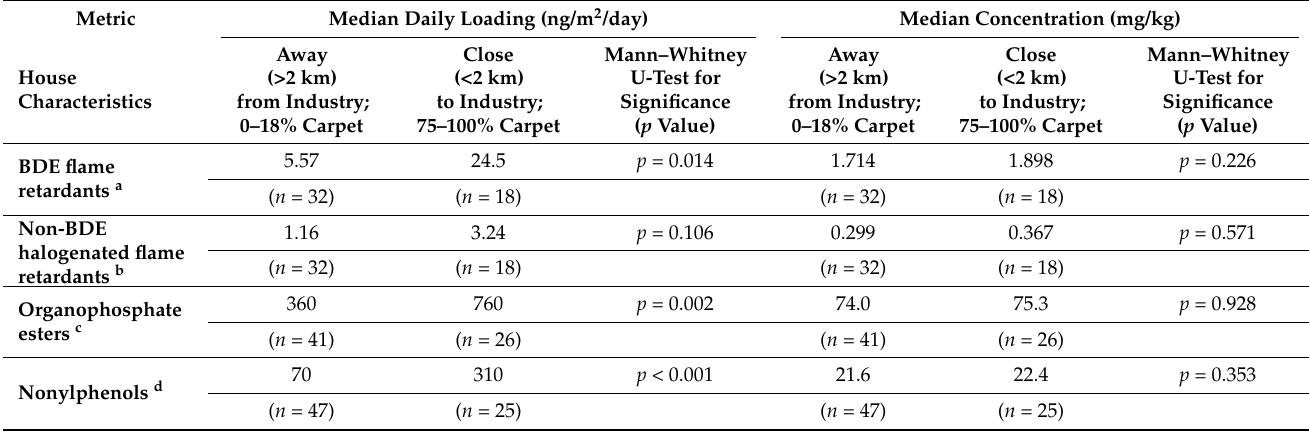
Figure 3. Summed exposures to four classes of co-occurring organic compounds in children’s homes: influence of carpet and proximity to industry. Median loading rates based on 80 µ m dust size fraction (see Table 8 for significance and number of homes in each subset). Table 8. Comparison of metrics (loading versus concentration) for determining influence of house characteristics on combined exposures to organic compounds in children’s homes shown in Figure 2. ( n = number of homes in each subset; 80 µ m dust size